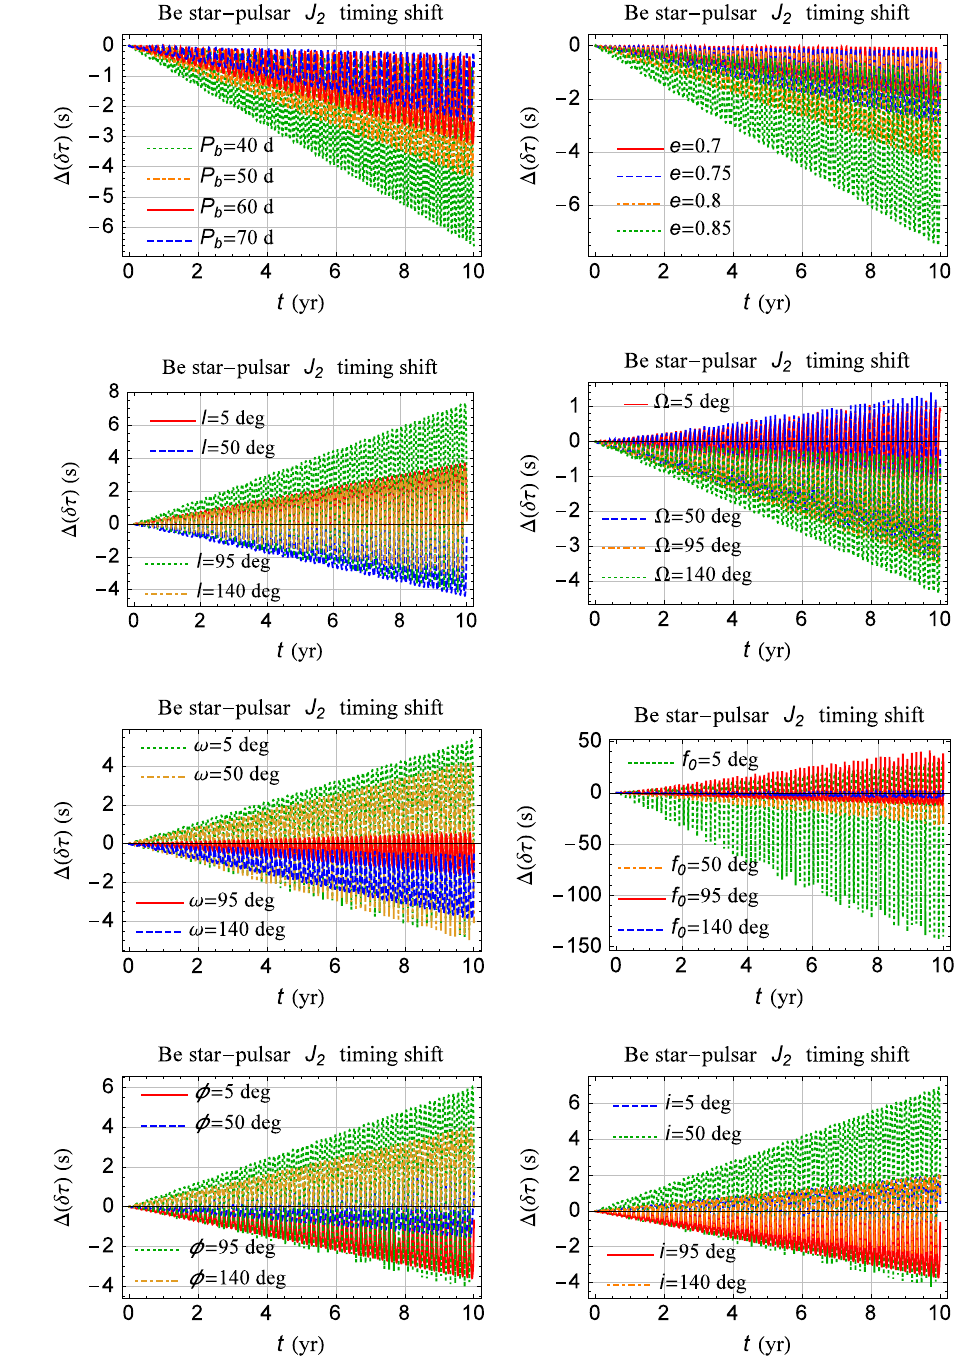
Fig. 1 Numerically integrated time series of the timing shift (cid:4)(δ τ ) due to Eq. (5), in s, for variations of the parameter space of a fictitious binary pulsar, characterized by P b = 50 days , e = 0 . 8 , I = 50 deg , (cid:12) = 140 deg , ω = 149 deg , f 0 = 228 deg, orbiting a Be-type star with M = 15 M (cid:2) , R e